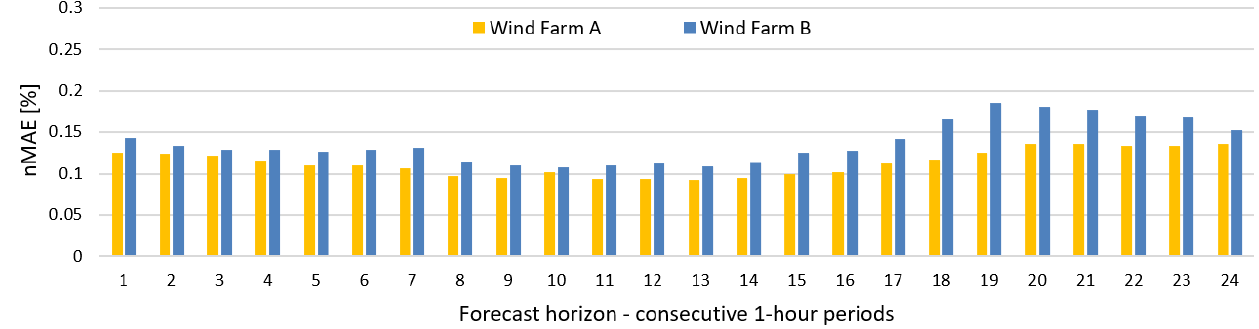
Figure 25. Forecast error depending on the forecast horizon for the test subset for both wind